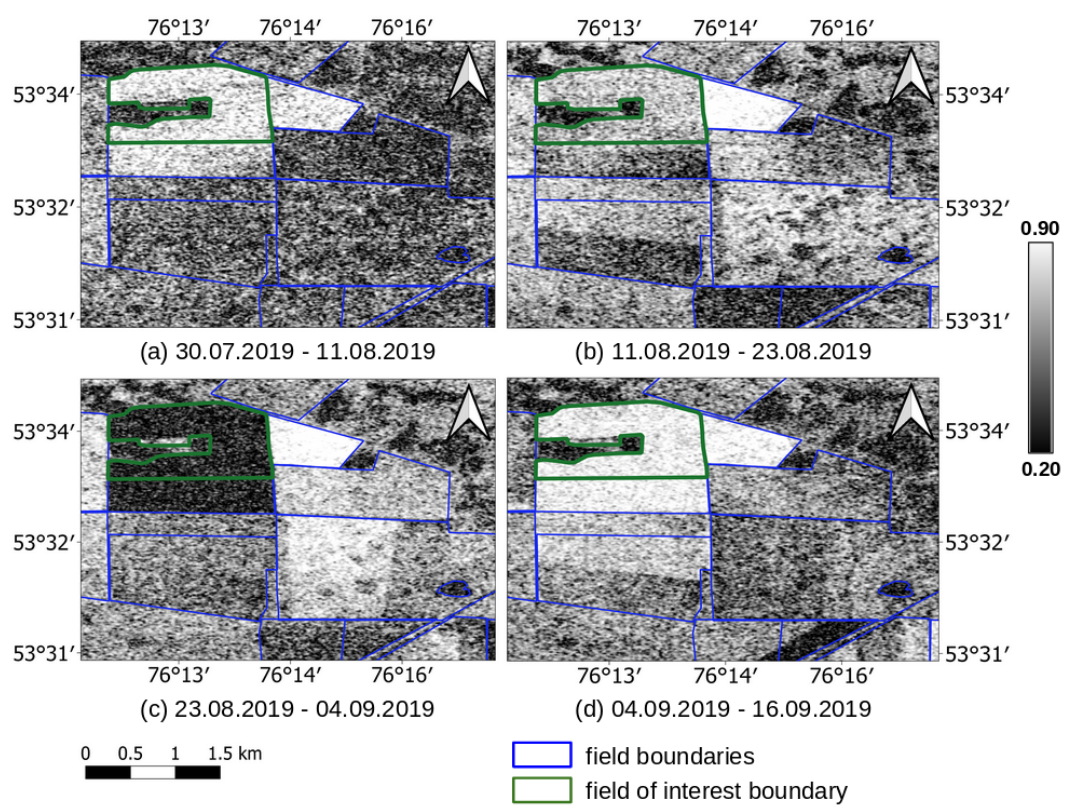
Figure 8. The general pattern of VV coherence changes during the cereals harvesting period (Kazakhstan), harvesting: 23 Augus–4 September